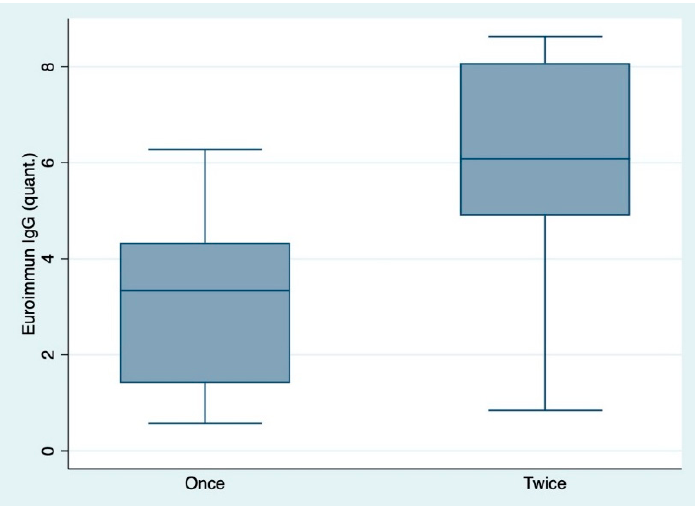
Figure 2. Box-plots indicating the difference of IgG antibody titers (as ratio of the patient sample over the extinction of the calibrator) among individuals who received one or two vaccinations. “quant.”: quantitative IgG titers. Once: one vaccination only. Twice: two vaccinations.